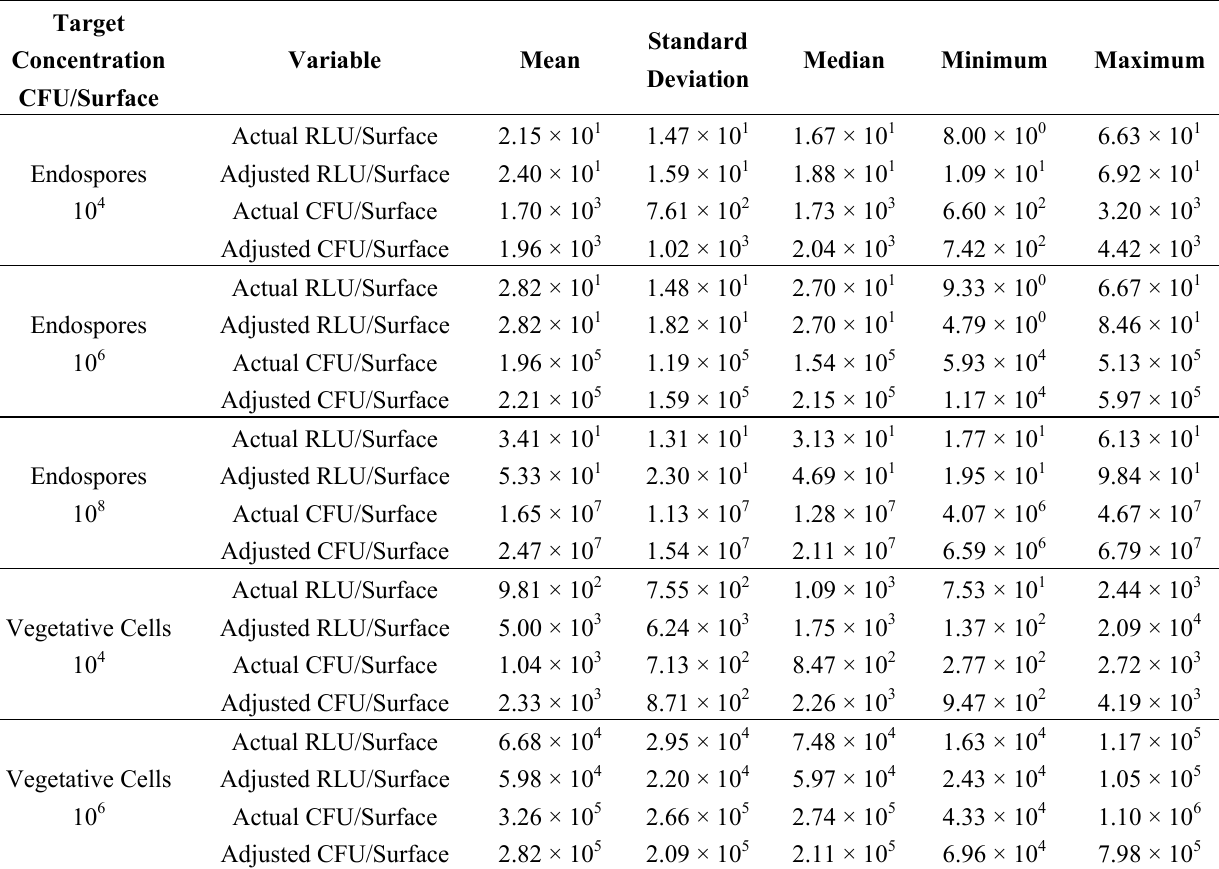
Table 2. B. anthracis Sterne 34F2 (endospore and vegetative cell) concentrations on surfaces *